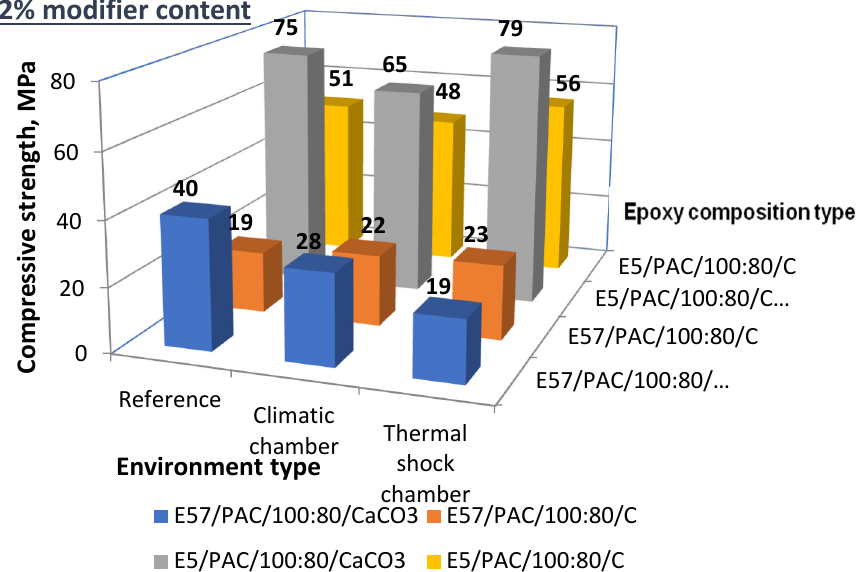
Figure 28. Compressive strength of the 2% filler epoxy compounds post-aging under different conditions.